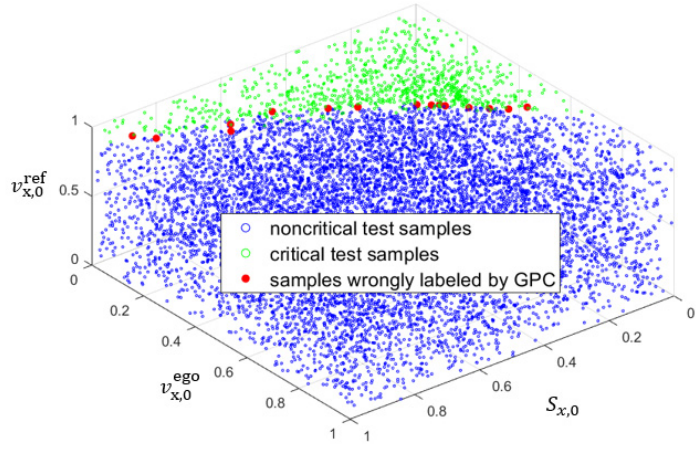
Figure 9. Test samples labeled by GGPC.